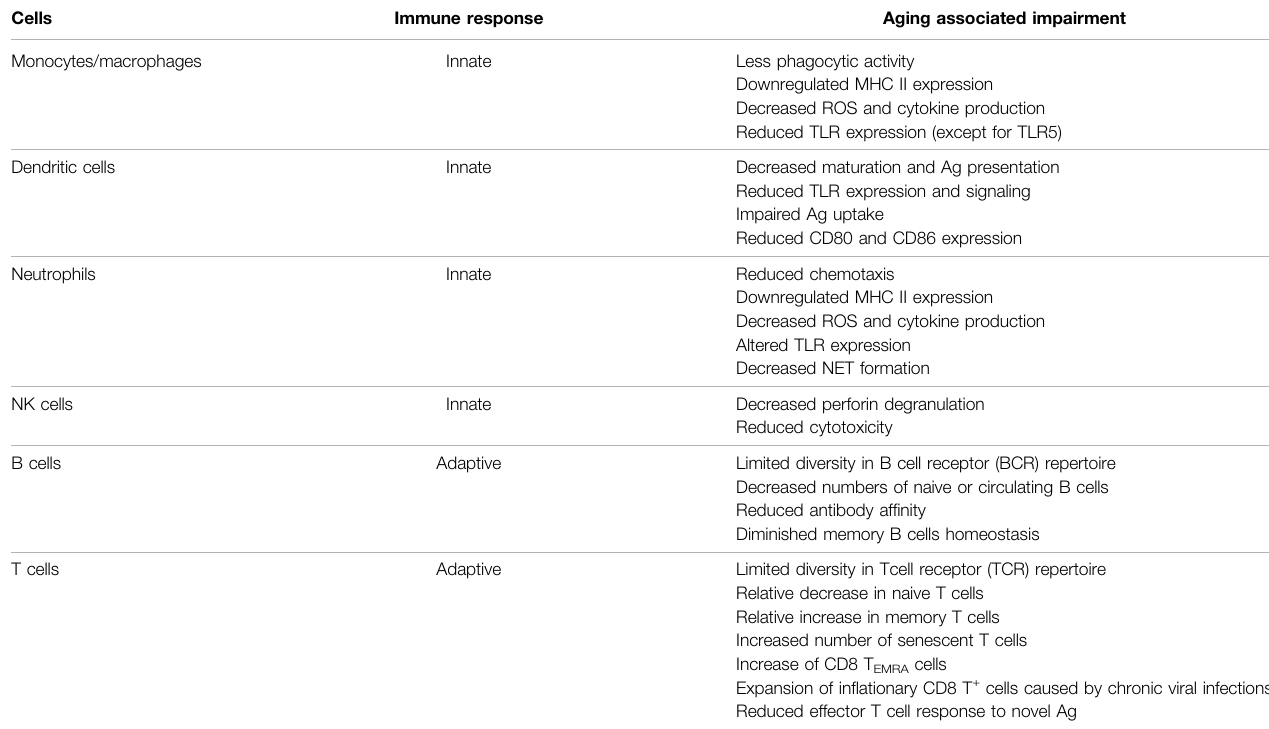
TABLE 1 | Age related changes in the immune system are summarized below.